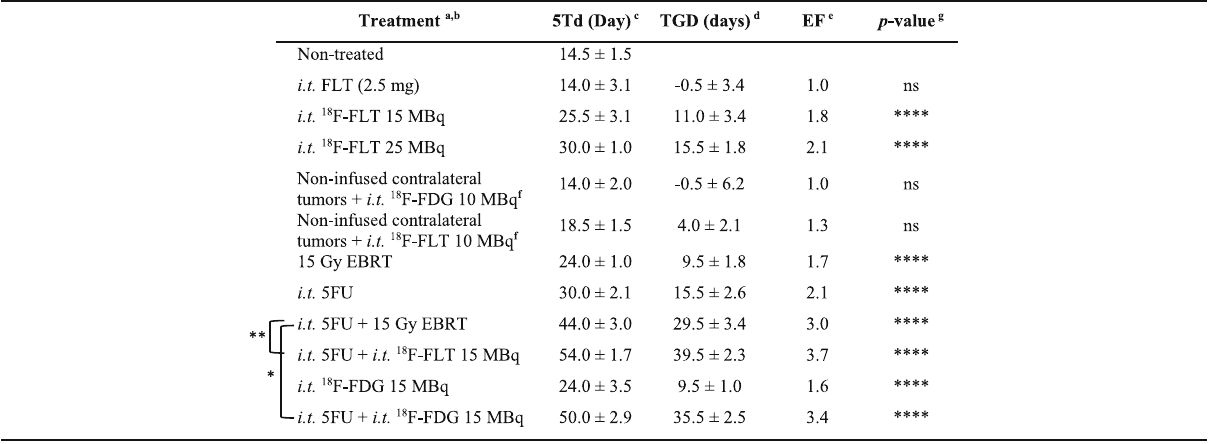
Table 1 Therapeutic efficacy of 18 F-metabolic TRT or EBRT, alone, or combined with i.t. 5FU in the HCT116 human colorectal cancer xenografts